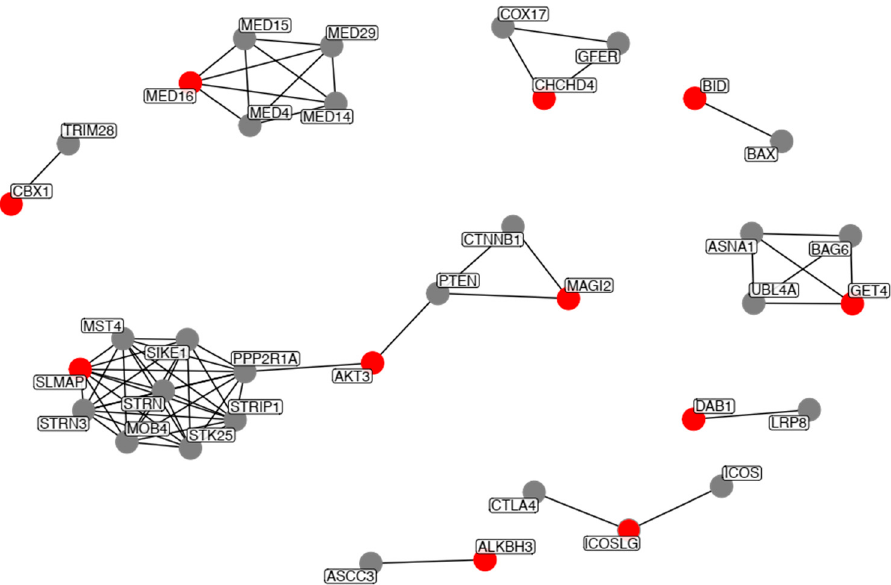
Figure 3. STRING network analysis of the genes potentially modulated by TEs. Input genes are highlighted in red, whereas interacting partners reported by STRING are in grey. Only direct interactions to each of our query genes are shown.